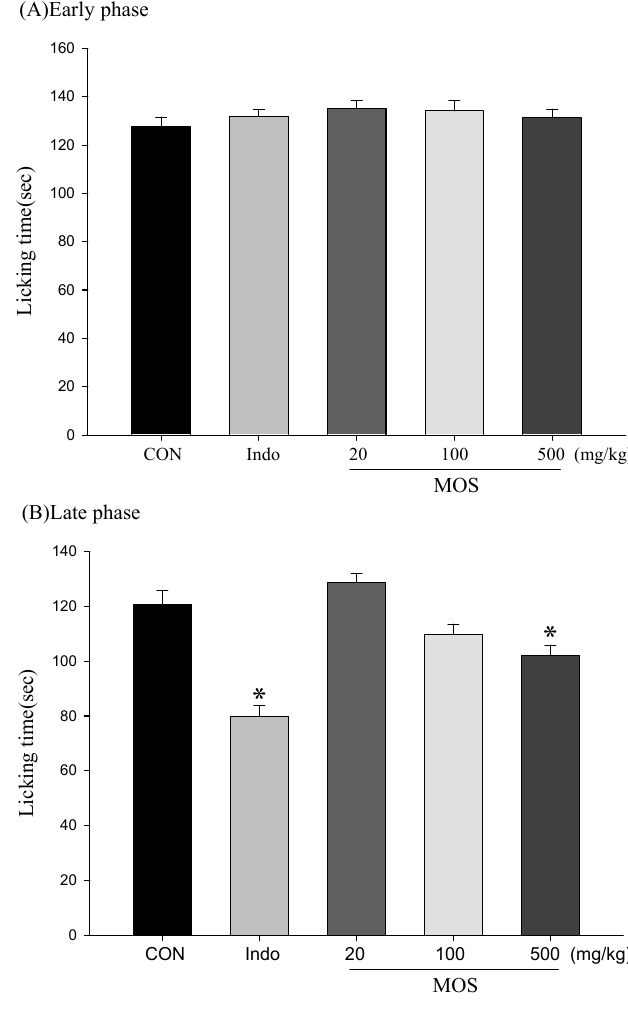
2.5. MOS -Inhibited Carrageenan-Induced Edema and Inflammation in Mice Paw Tissue EtOH Carrageenan-induced mice paw edema is a biphasic process. During early hyperemia, which occurs 0–2 h after the carrageenan injection, there is a release of histamine, serotonin, and bradykinin that results in increased vascular permeability. The inflammatory edema reached its maximum level during the second hour and then begins to decline. In our study, paw edema was increased and reached a maximum at 2 h after carrageenan injection. Treatment with MOS (20, 100 and 500 mg/kg) EtOH significantly reduced paw edema formation ( p < 0.001) as shown in Figure 4. The inhibition rate at 2 h (20, 100 and 500 mg/kg) or was 45% to 55% after treatment with MOS EtOH